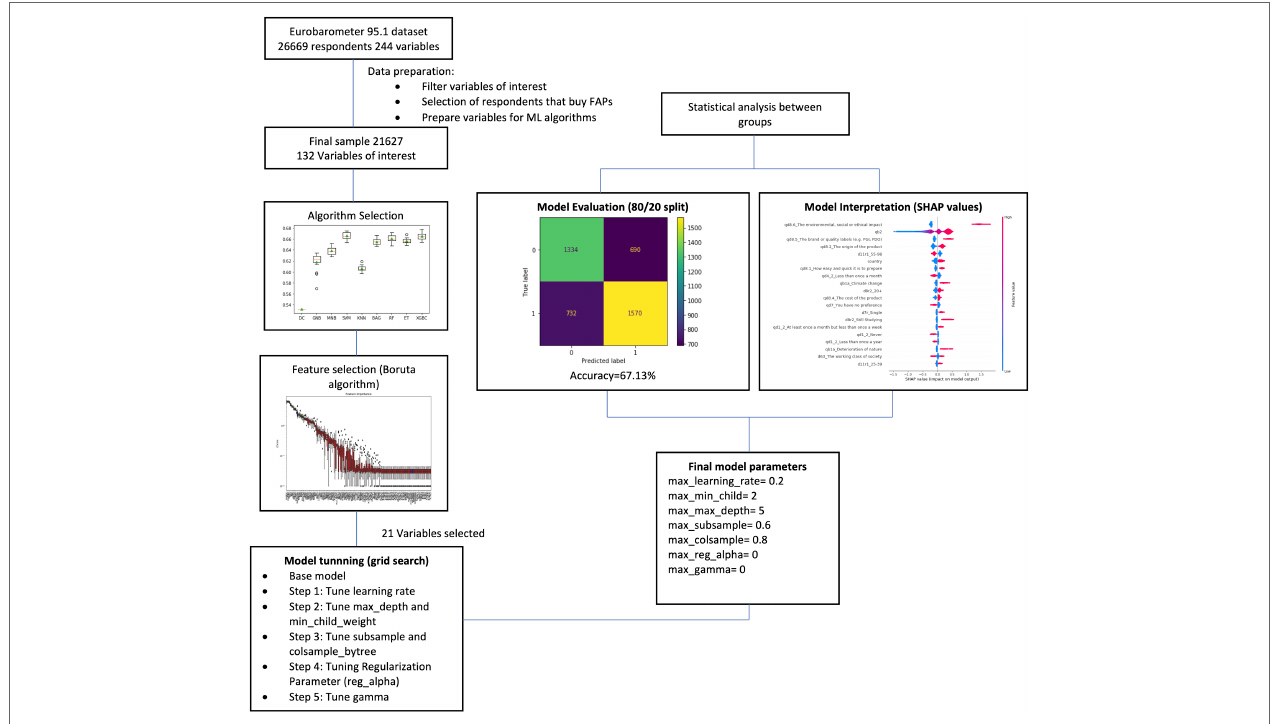
FIGURE 1 | Methodological process of the